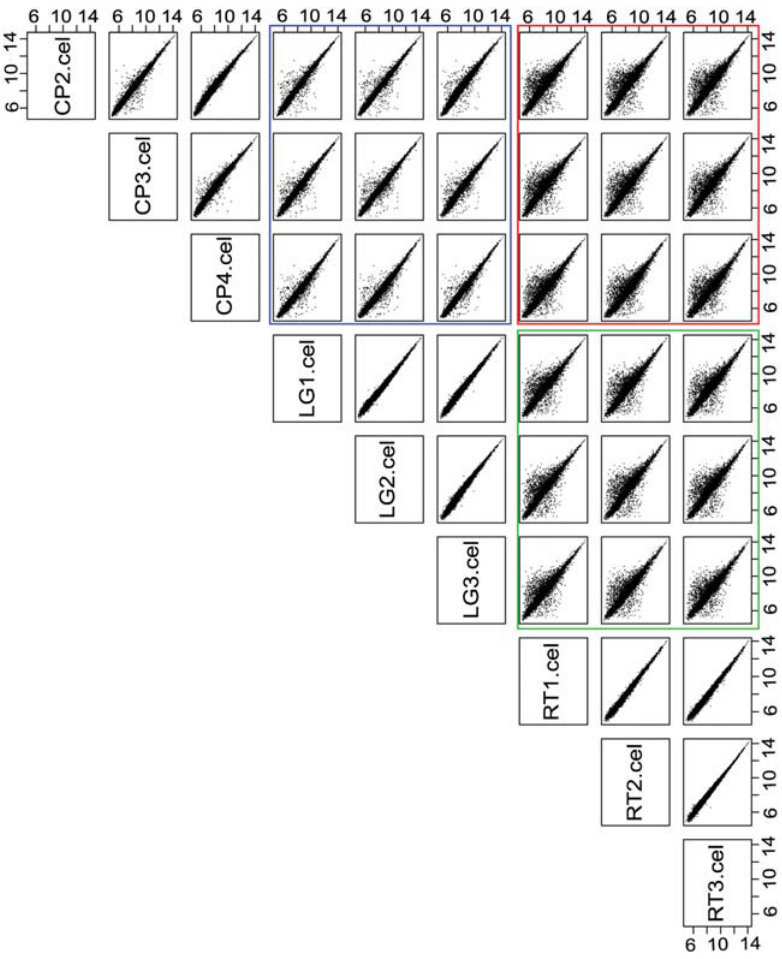
Figure 2. Pair-wise scatter plots for the raw PM probes intensity data across all arrays. The intersection of 12000 randomly chosen features/probes data for CP and LG is boxed in blue, for CP and RT in red and for LG and RT in green respectively. The biological replicates of each variety are highly correlated as features are falling along diagonal line. CP=Cypress, LG=LaGrue, RT=RT0034 and PM=perfect match.